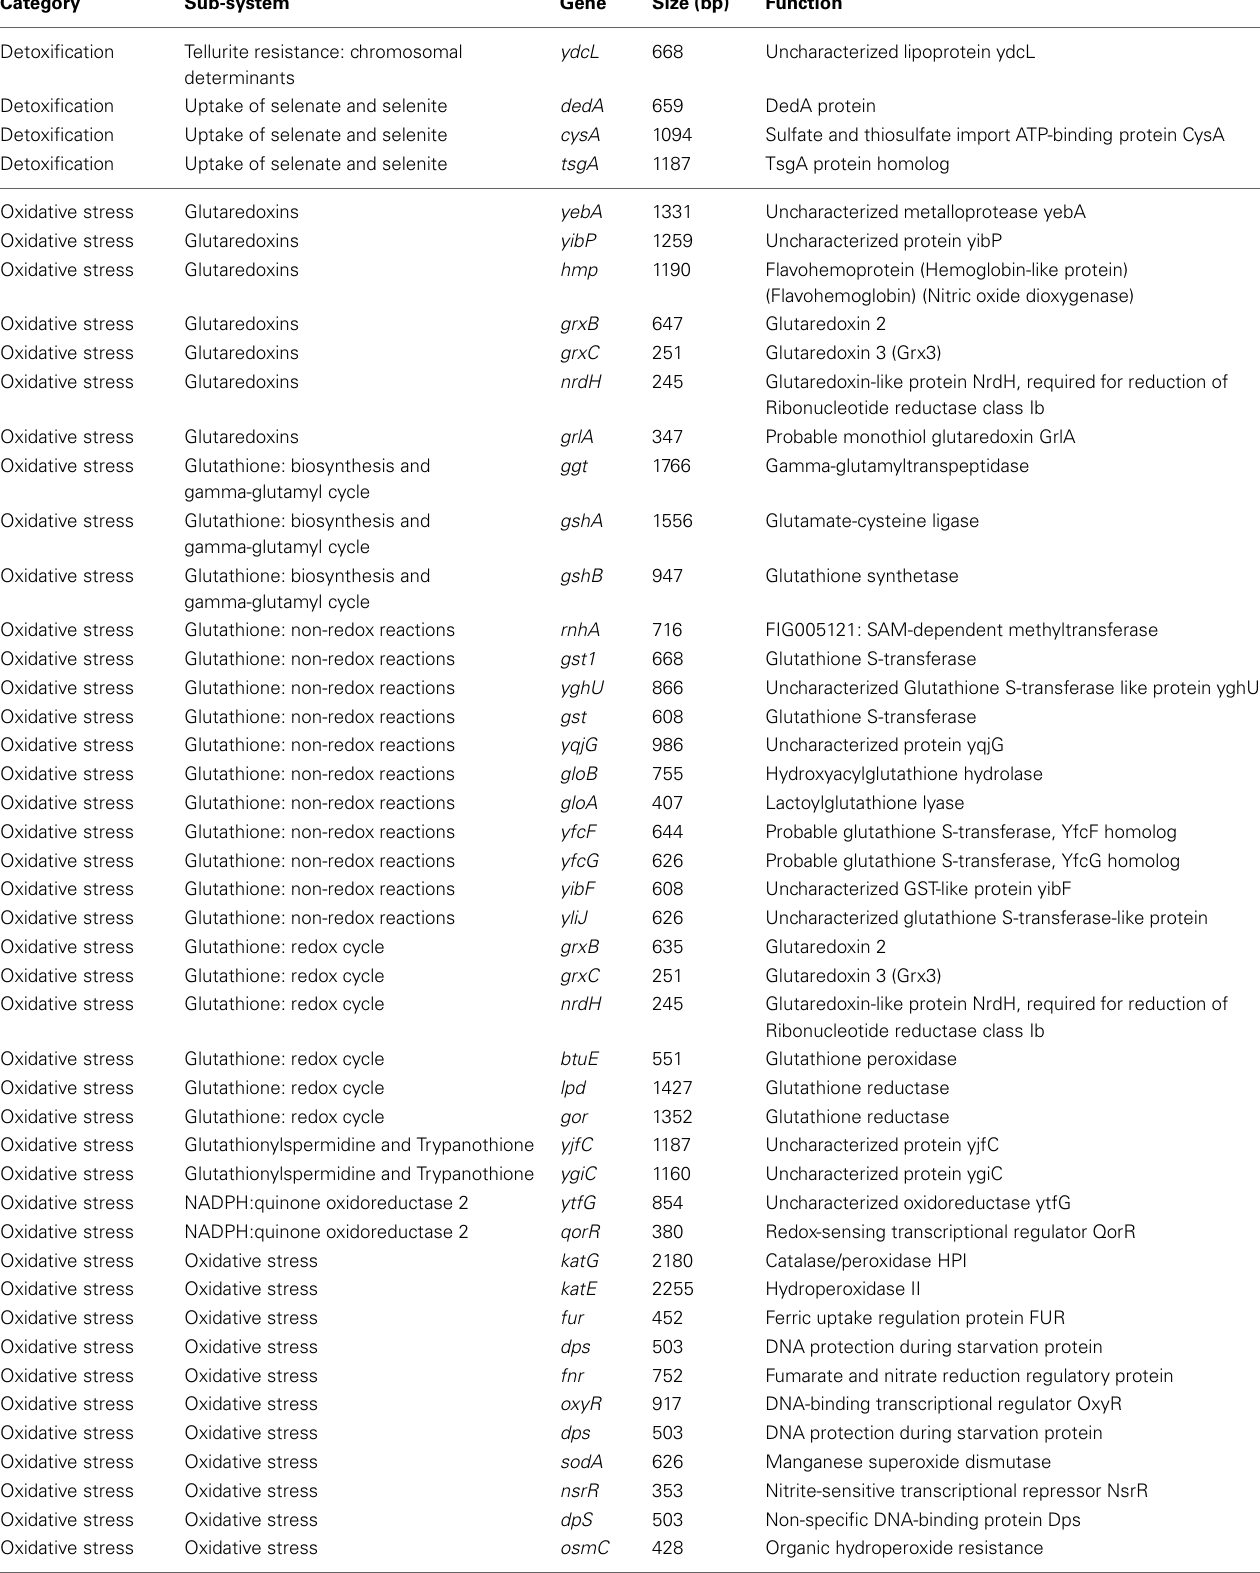
FIG005121: SAM-dependent